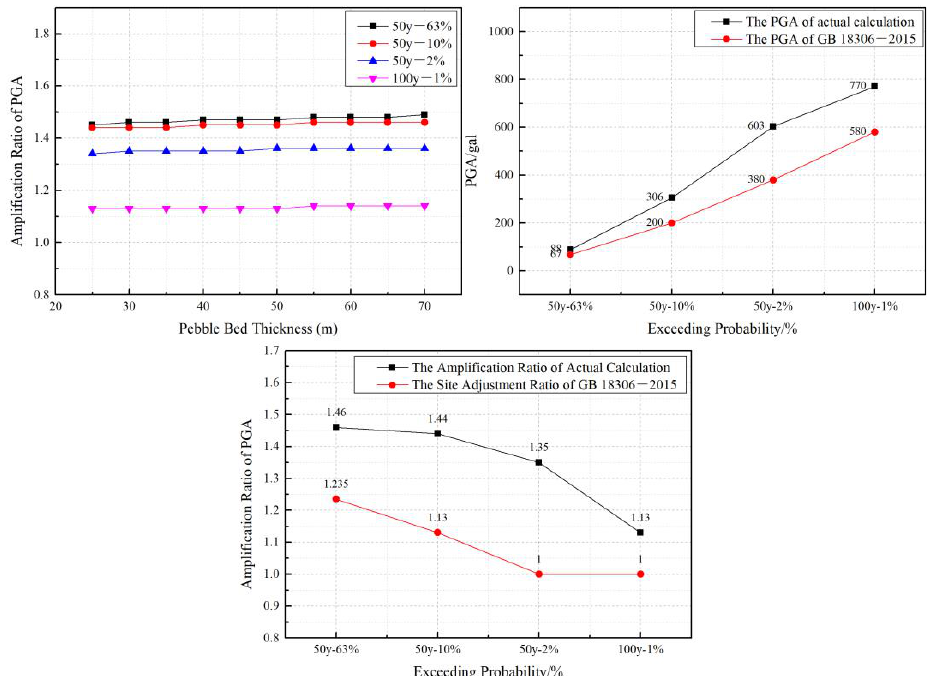
Figure 5. Amplification ratios of ground motion for the different thicknesses of pebble layer under four seismic inputs.